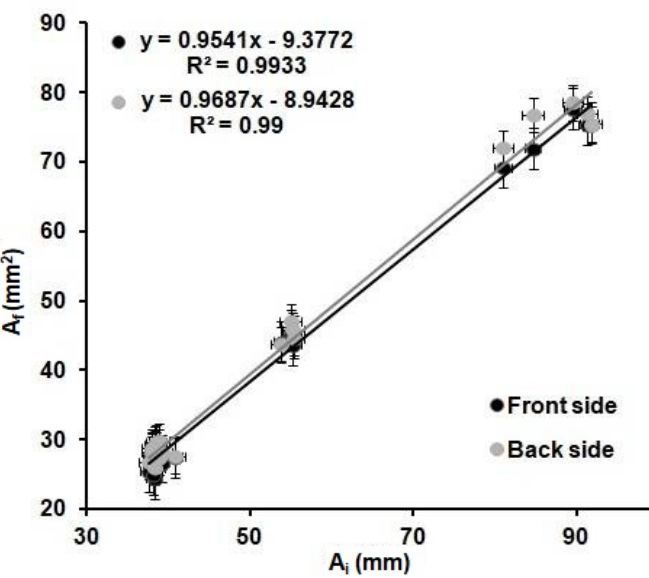
Figure 4. Relation between the internal before heating, A i , of the printed devices, and the internal area after heating, A f , of the devices for 6 min at 125 °C; front (black) and back (grey) sides of the devices from Table 2 ( n = 8 per device).